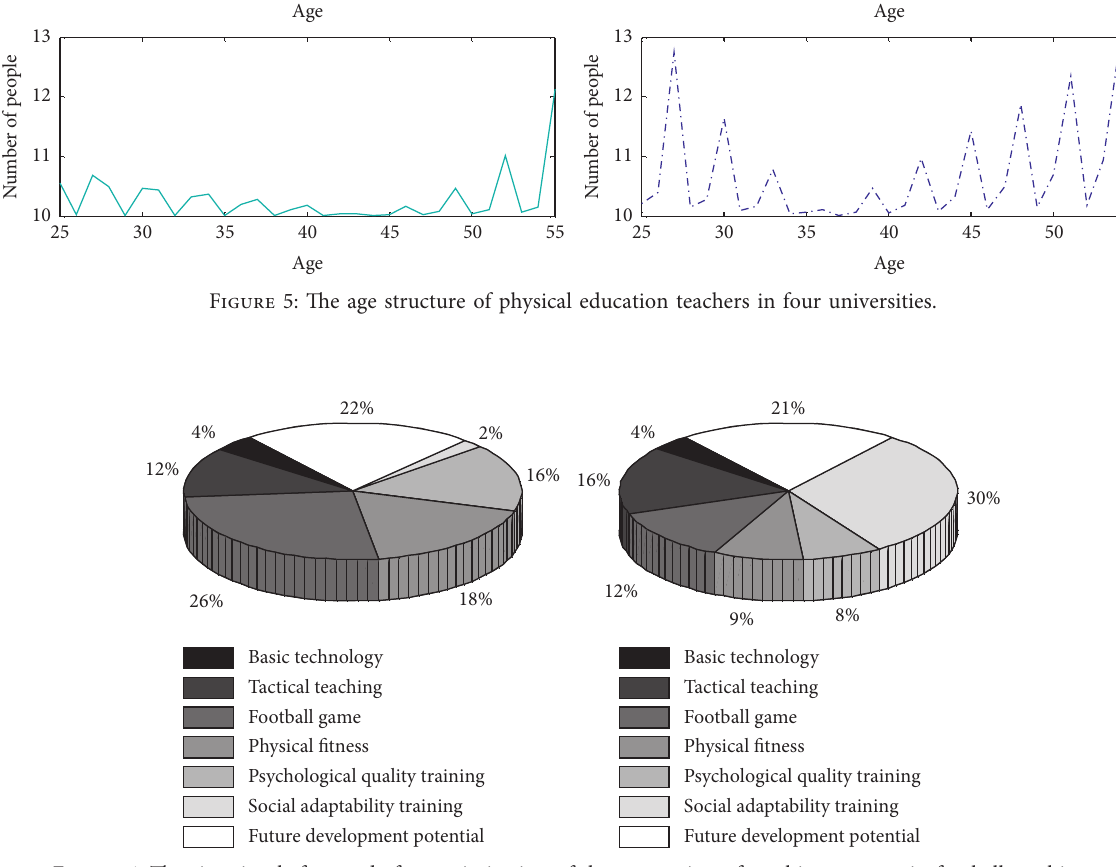
Figure 6: The situation before and after optimization of the proportion of teaching content in football teaching.